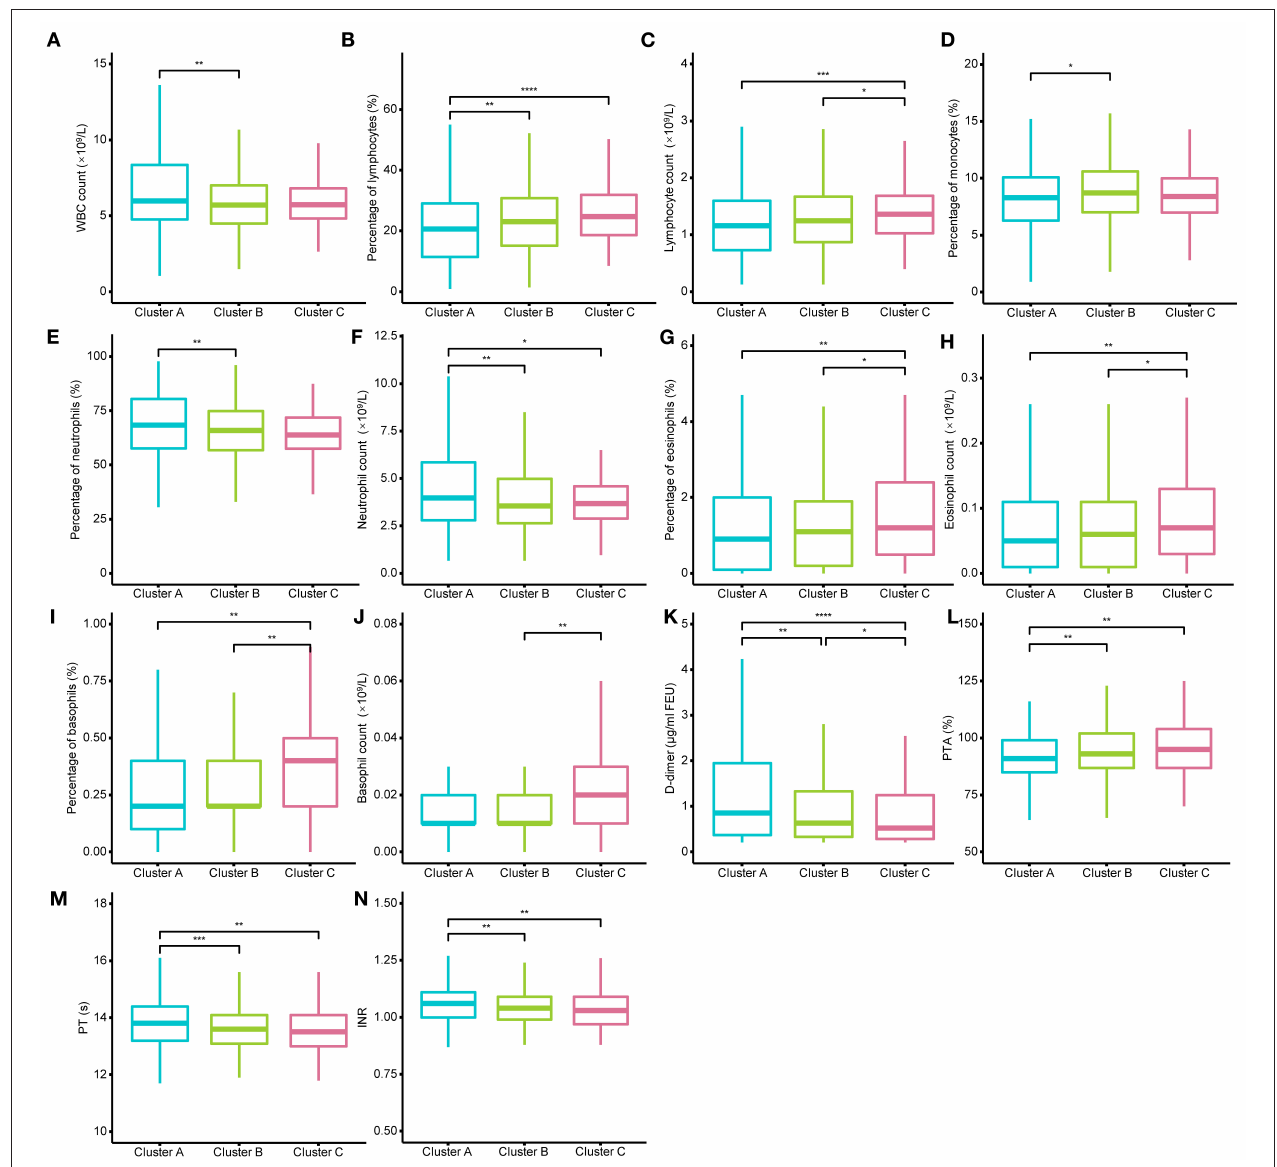
FIGURE 4 | Different levels of routine blood tests and coagulation function among the three clusters. (A–N) show the different levels of white blood cell (WBC) count, percentage of lymphocytes, lymphocyte count, percentage of monocytes, percentage of neutrophils, neutrophil count, percentage of eosinophils, eosinophil count, percentage of basophils, basophil count, D-dimer, prothrombin time activity (PTA), and prothrombin time (PT), international normalized ratio (INR). D-dimer could well distinguish the three clusters. The Kruskal–Wallis tests with Dunn’s posttest was performed, and p -values were adjusted by the Benjamini–Hochberg procedure. * p < 0.05; ** p < 0.01; *** p < 0.001; **** p <